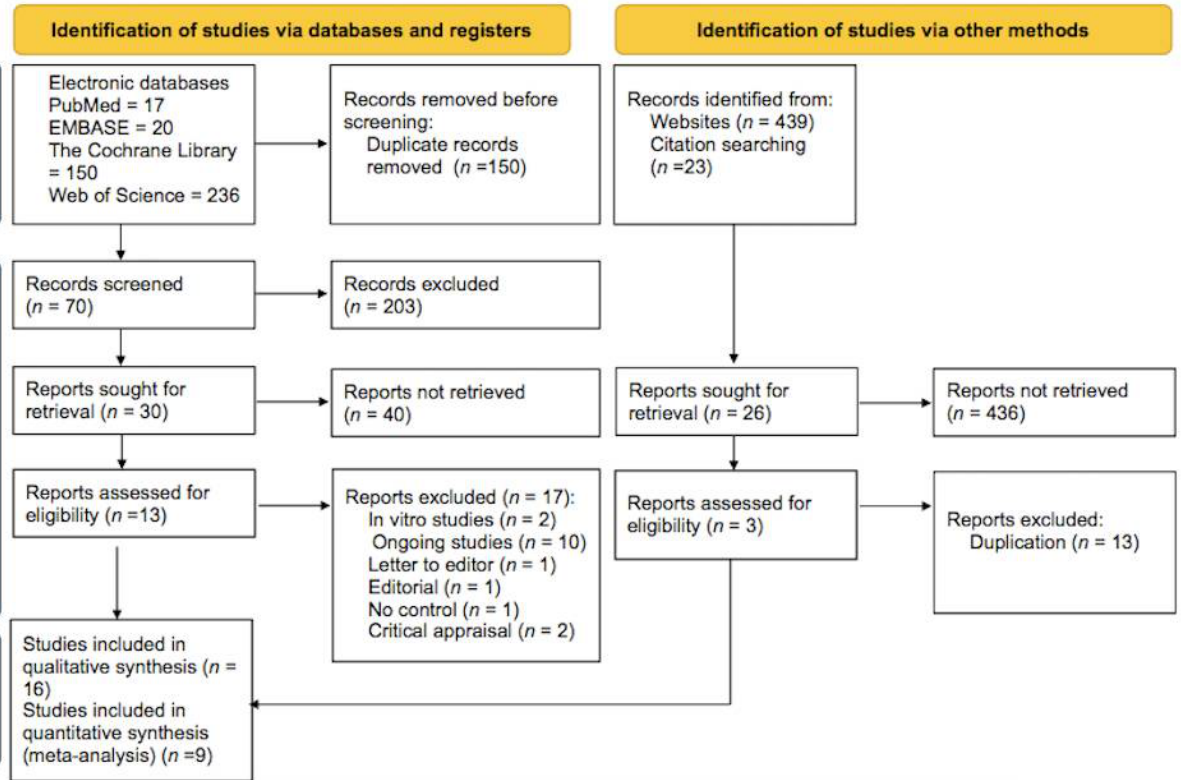
Figure 1. PRISMA 2020 flow diagram for the systematic reviews and meta-analysis.